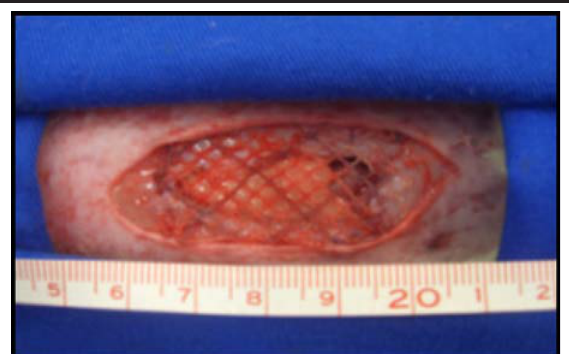
FIGURE 4 - Closing of the deformity with Vypro® mesh.